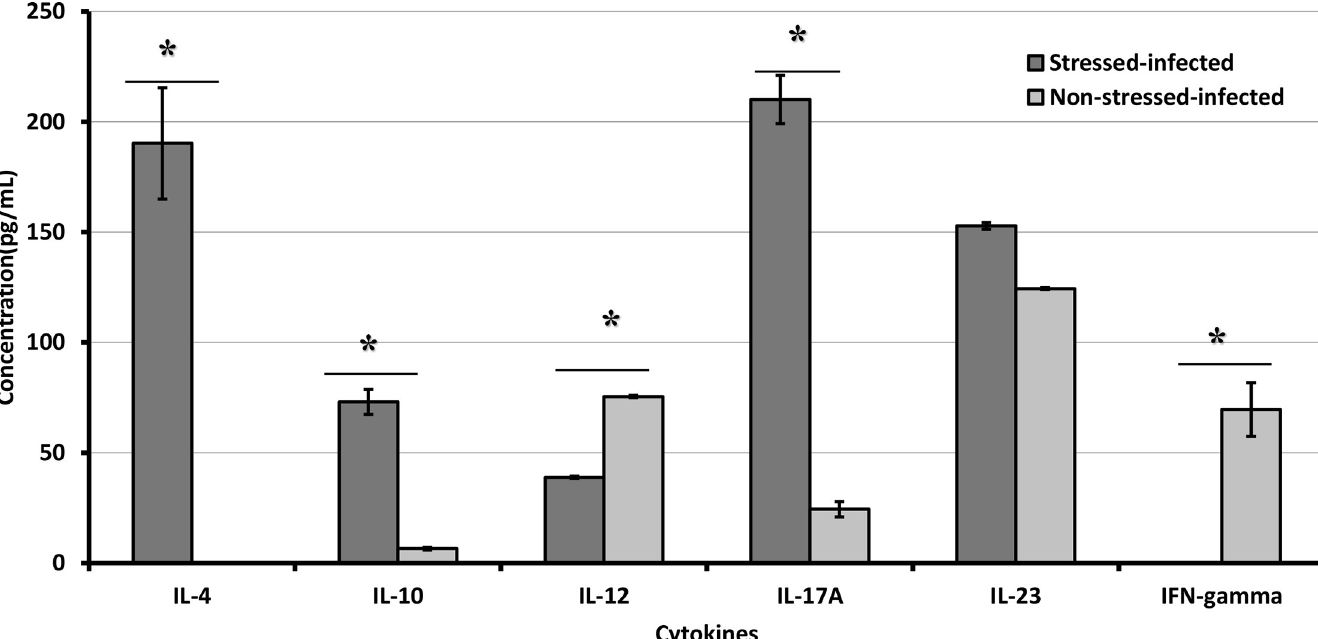
Fig 10. Cytokine production kinetics of CD4+T cells and dendritic cells co-cultured in vitro . CD4+ T cells from stressed and non-stressed mice isolated by negative selection were co-cultured for 48 h. Shown data are mean+/_SEM two or more independent experiments performed on separate dates. � Denotes statistically significant differences between stressed and non-stress mice.